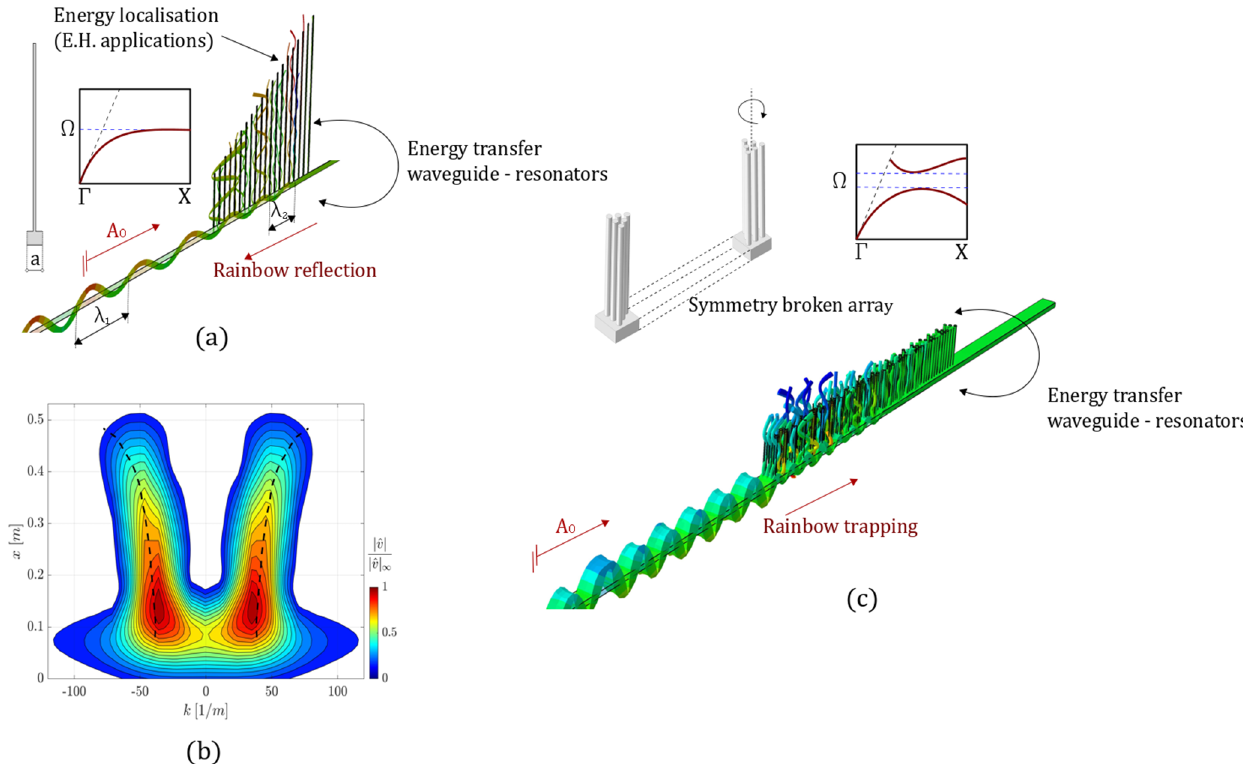
Fig. 1. (a) Elastic waveguide with a graded array of resonators of increasing height. Since the zero-group velocity mode is met at the edge of the Brillouin Zone, after a certain amount of time the input wave is re fl ected. While the wave propagates, the amplitude and the wavelength decrease due to energy transfer between the waveguide and the resonators. This is shown in the experimental spectrogram in (b) obtained for a rainbow re fl ection device in the kHz range. Due to this energy transfer, this mechanism is useful to harvest energy in the resonators. Contrary to rainbow re fl ection, rainbow trapping is obtained through a symmetry broken array, where an accidental degeneracy is lifted, resulting in zero group velocity modes within the fi rst Brillouin zone. This allows to reduce re fl ections and to increase the energy available inside the array for